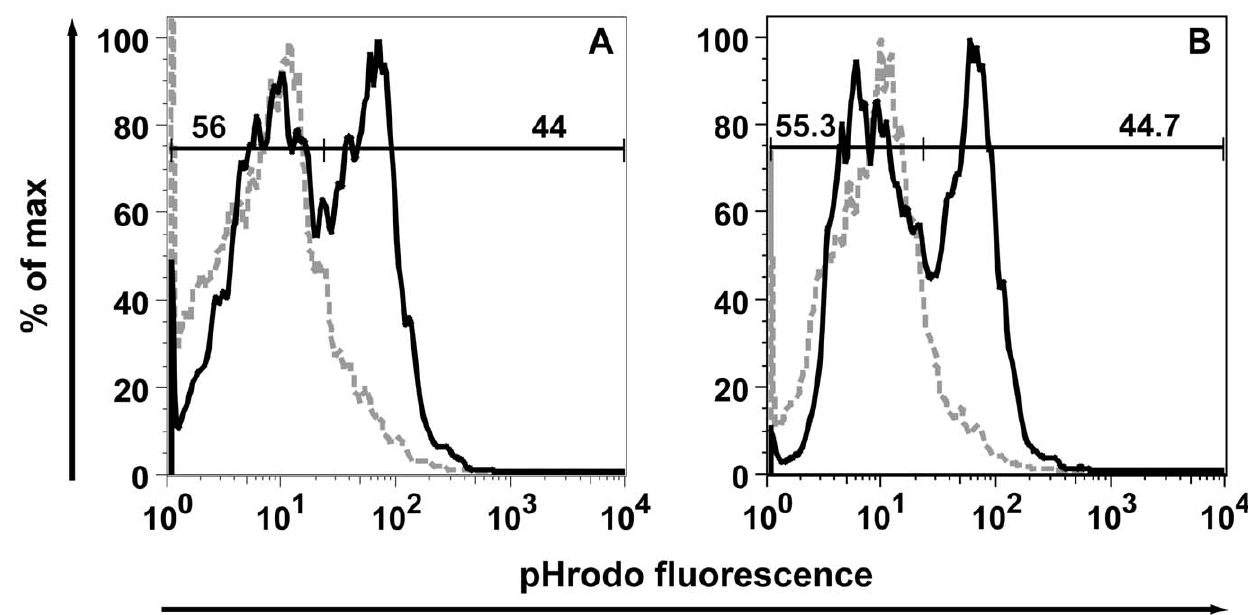
Figure 6. IRF8-deficient microglia show no defect in E.coli particle phagocytosis. Flow cytometry analysing pHrodo fluorescent E.coli particle uptake after 3 h by WT (A) and IRF8-deficient (B) primary microglia (grey dashed line=4 u C control assay, black continuous line=37 u C). Cells were gated for eGFP and CD11b (CD11b-PerCP-Cy5.5) and pHrodo fluorescent E.coli particle uptake was determined by measuring signal increase in the red fluorescence channel